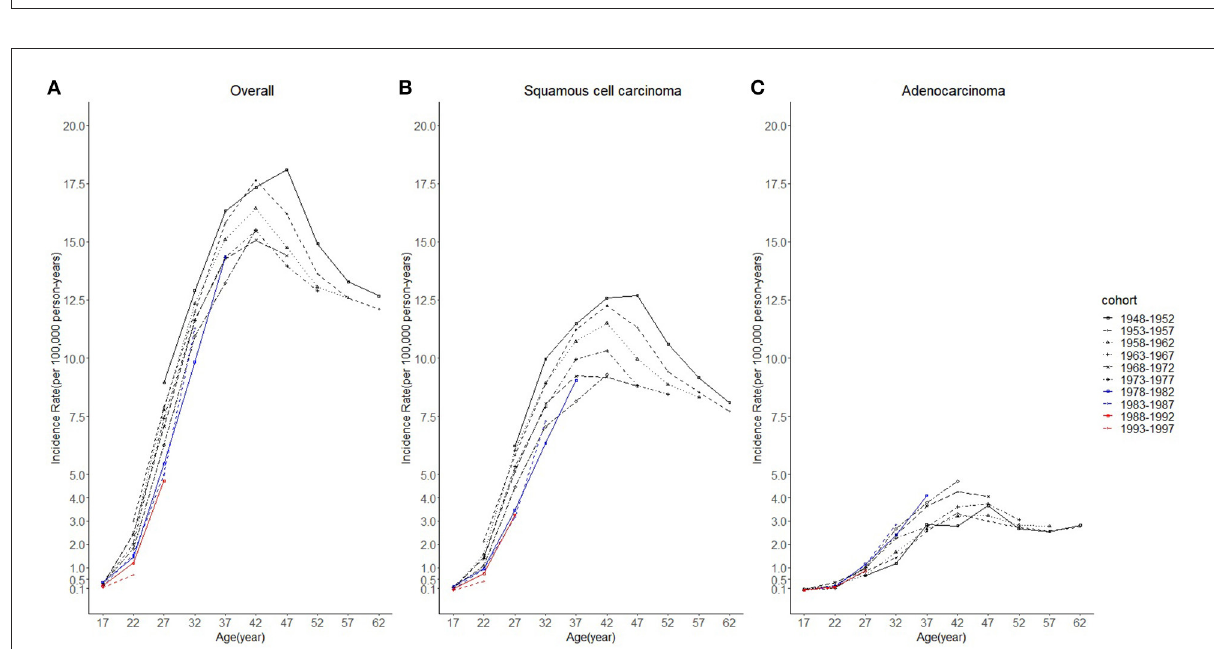
FIGURE4 Age trends in cervical cancer incidence rates (1975-2019) among females in 1948-1997 birth cohorts by cohort and histology, United States. (A) Age trends of all histopathologic subtypes combined. (B) Age trends of squamous cell carcinoma (SCC). (C) Age trends of adenocarcinoma (AC). All data are expressed as the rate per